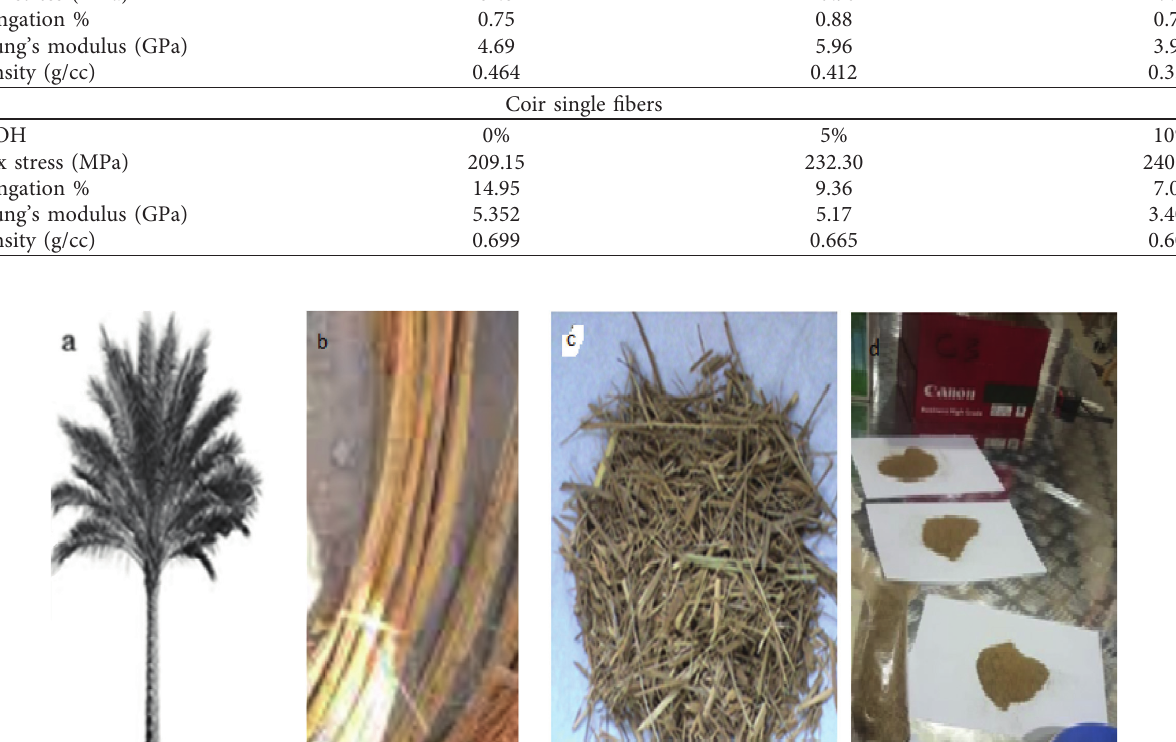
Figure 3: Extraction of date palm frond (DPF) fibers.